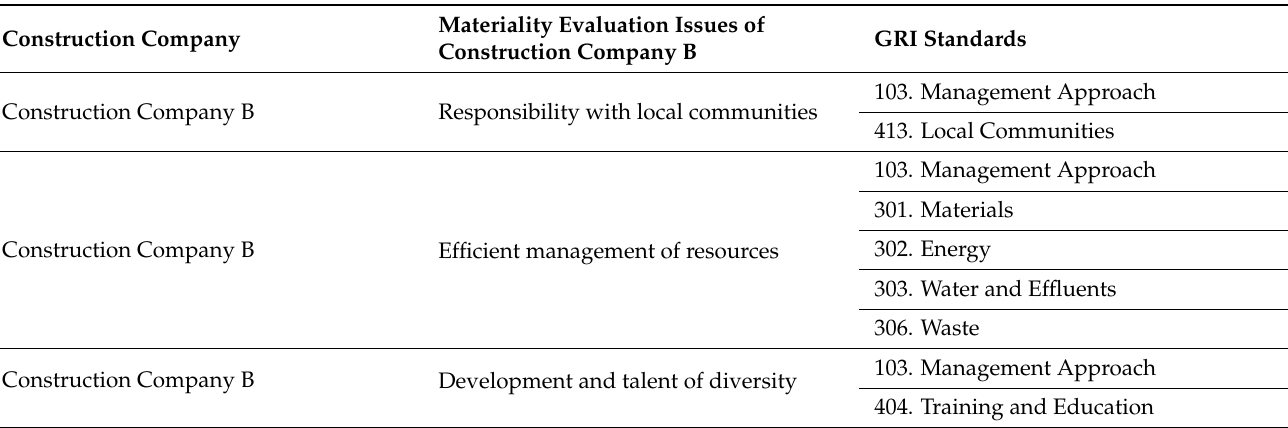
Table 7. GRI table for global construction company